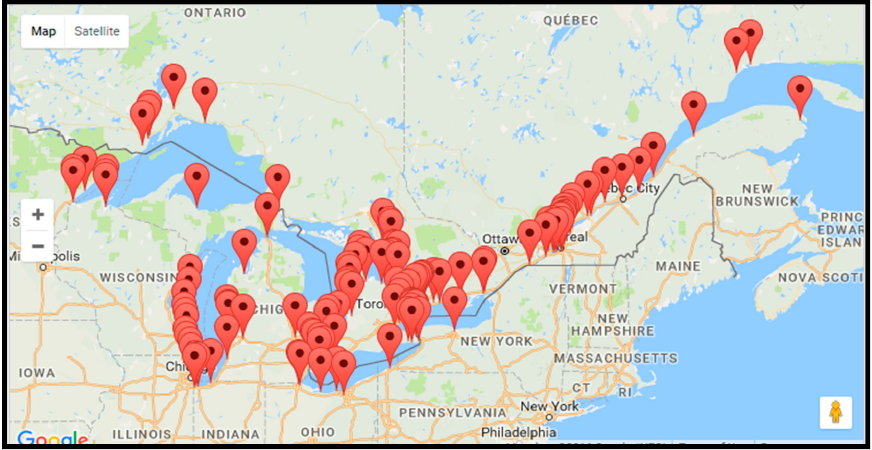
Figure 2. Map showing member cities of the Great Lakes and St. Lawrence Cities Initiative